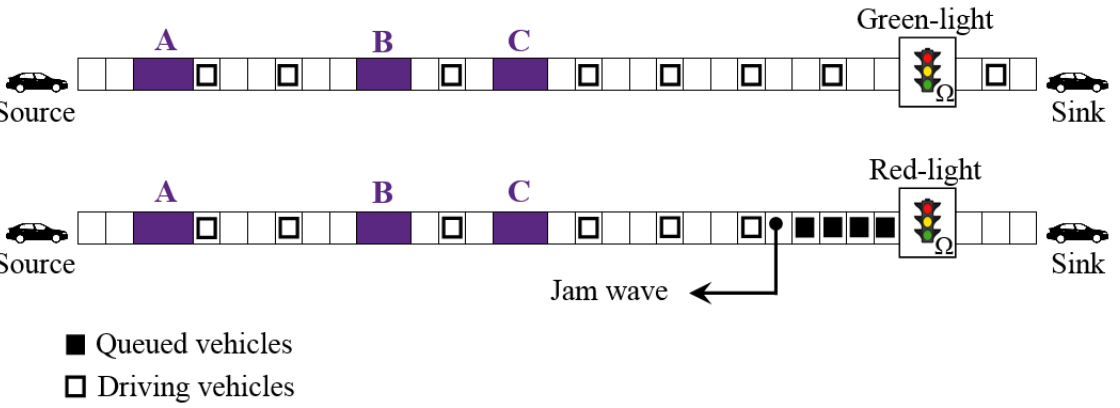
Figure 5. Schematic diagram describes the formation of travelling jam moves towards three different locations A, B, and C. locations A, B, and C.